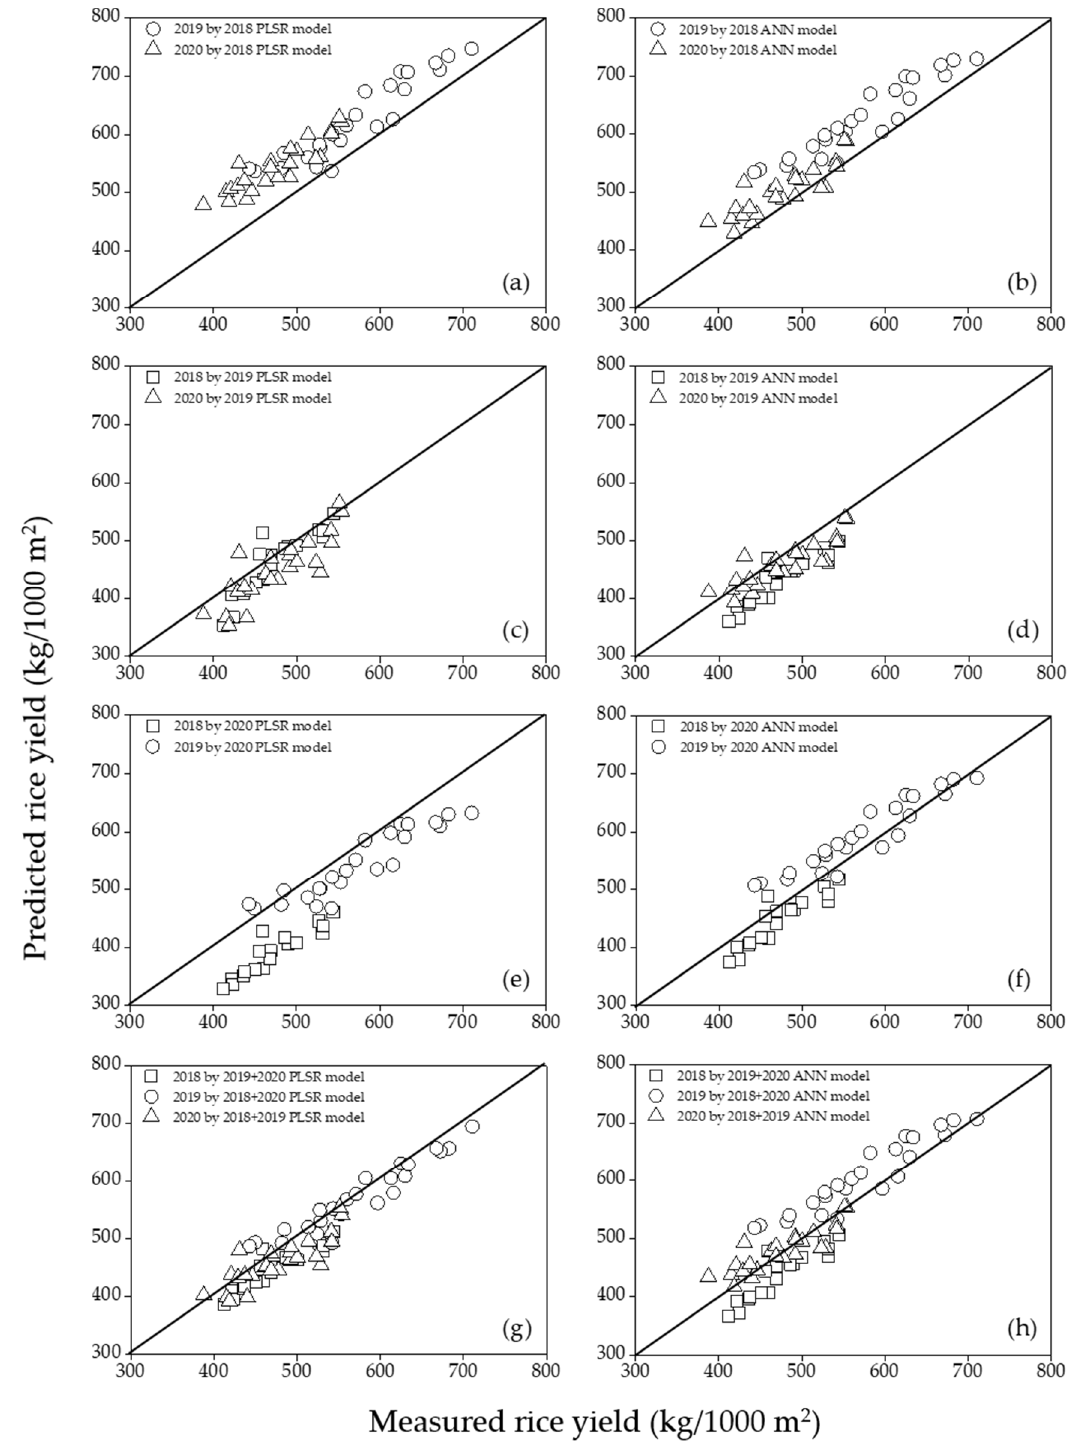
Figure 4. Mutual rice-yield predictions by the PLSR models ( a , c , e , g ) and the ANN models ( b , d , f , h ) for single- and multi-year analyses.